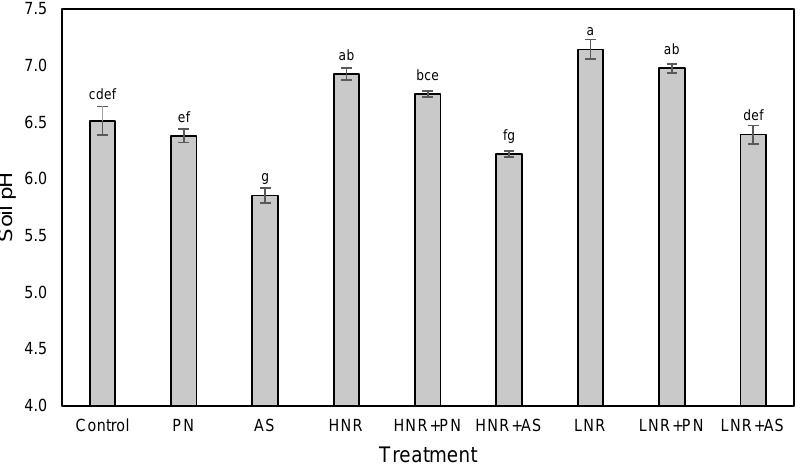
Figure 4. Soil pH during a 60 d aerobic incubation involving an unamended control and the following eight treatments: potassium nitrate (PN), ammonium sulfate (AS), high N residue (HNR) with or without PN (HNR + PN) or AS (HNR + AS), and low N residue (LNR) with or without PN (LNR + PN) or AS (LNR + AS). Data shown as a mean from duplicate incubations for 7 and 60 d with standard error bars. Treatments do not differ significantly ( p < 0.05) when bars are accompanied by the same letter.